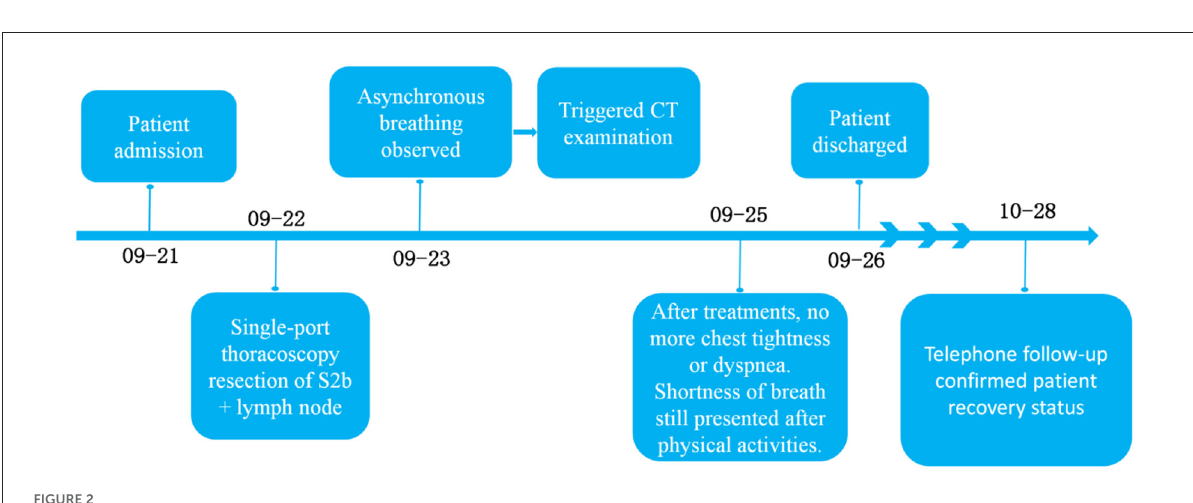
FIGURE2 Timeline of patient